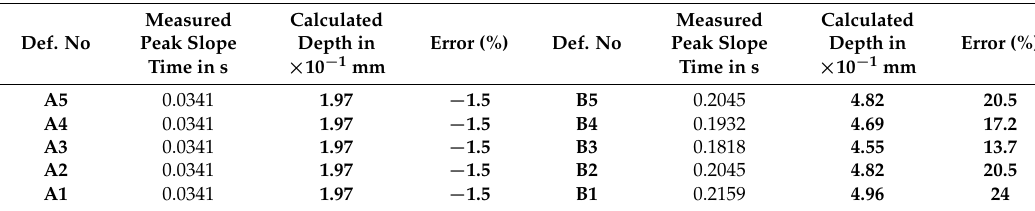
Table 2. Depth estimations for the defects of Series A and